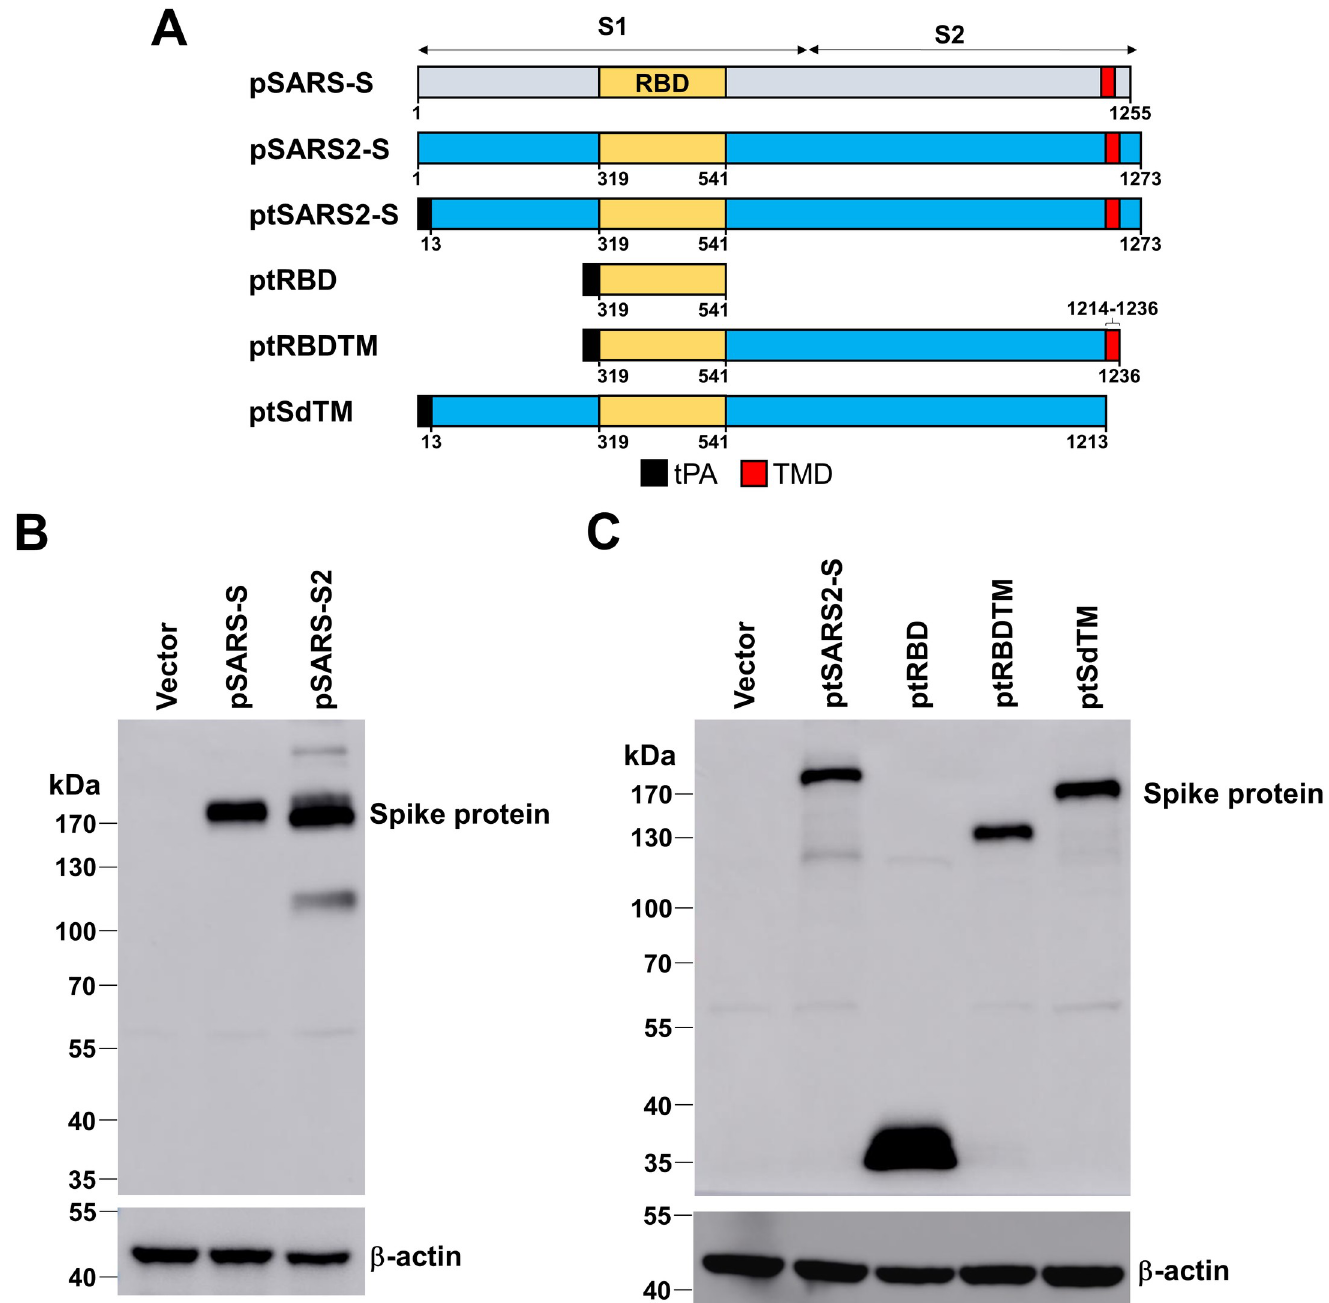
Fig 1. Design and expression of SARS-CoV and SARS-CoV-2 spike construct variants. (A) Schematic diagram of SARS-CoV and SARS-CoV-2 spike construct variants. tPA, leader sequence from tissue-plasminogen activator; TM, transmembrane domain. (B, C) Western blot analysis of spike protein. HEK293T cells were transfected with the indicated plasmids (vector, pSARS-S, pSARS2-S, and S variants fused with tPA leader sequence). The cell lysates were collected and probed with anti-Spike antibody, and anti- β -actin antibody was used as an internal control.